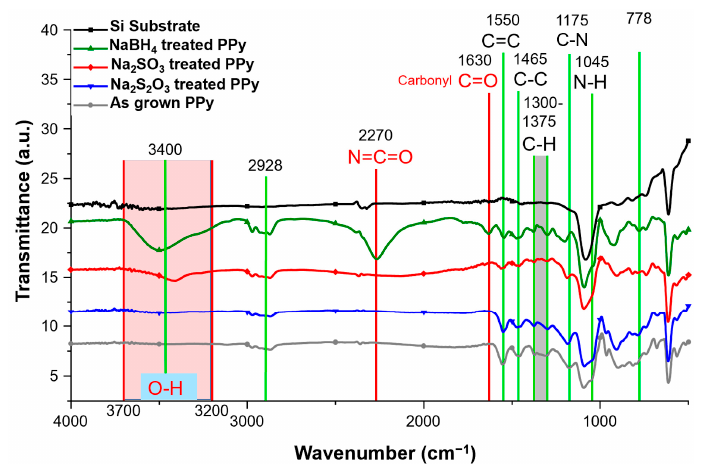
Figure 7. FTIR spectra of silicon reference substrate and PPy grown by VPP on a silicon substrate; measurements on PPy samples were performed after reduction treatments in Na 2 S 2 O 3 , Na 2 SO 3 and NaBH 4 10 wt% solution in demineralized water followed by rinsing in demineralized water.